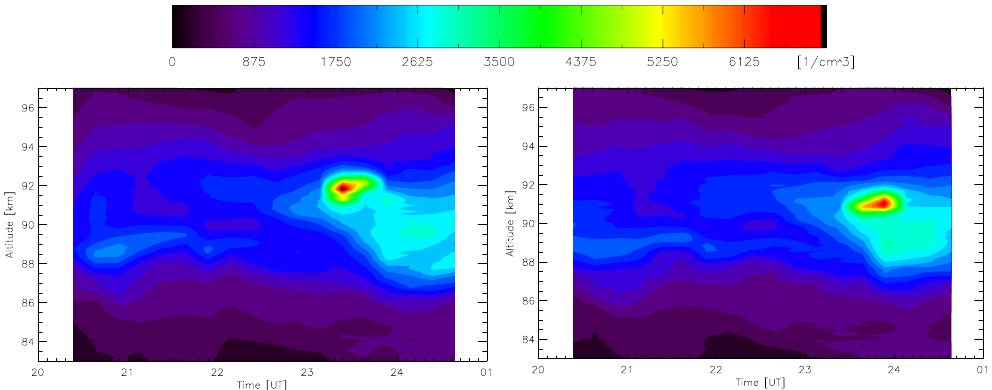
Fig. 1. Contour plots of 15min averaged density from the ALOMAR Weber Na lidar on 5–6 November 2005. Beam 1 (left) is pointing 20 ◦ W of zenith. Beam 2 (right) is pointing 20 ◦ E of